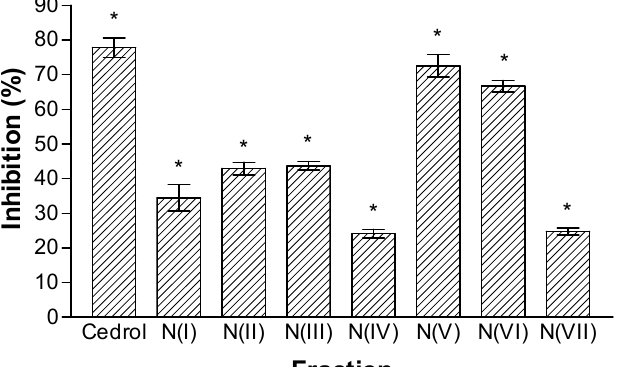
Figure 1. Inhibitory effects of the fractions (I–VII) on the PAF receptor binding to rabbit platelets at 18.2 µg/mL.